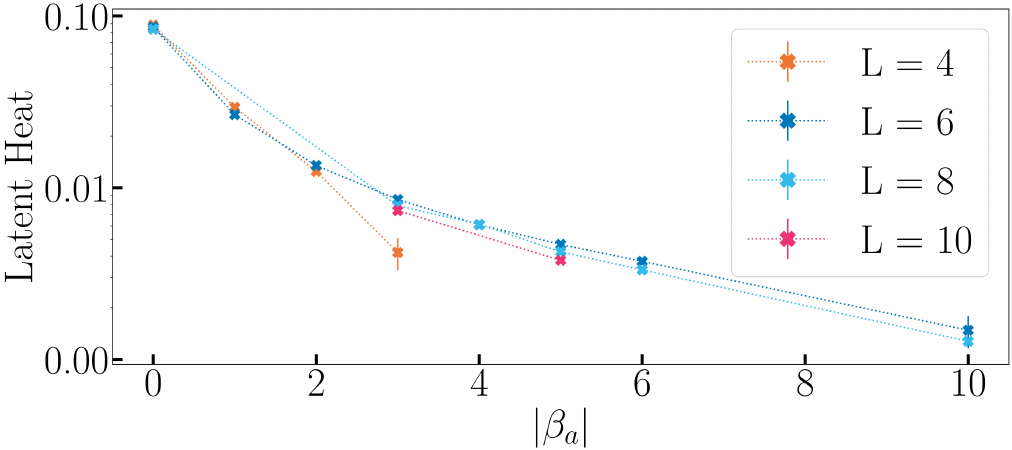
Figure 6 . Latent heat along the line of first order transition between phases I and III (shown in figure 3) for different lattice sizes. We observe a relatively strong dependence on the system size, especially for L = 4 , for which the latent heat disappears for β a < − 3 . Note that errors bars are plotted but often smaller than the marker